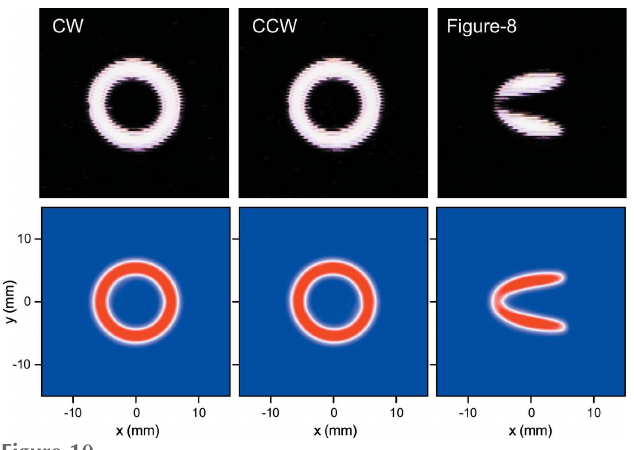
Figure 10 Top: profiles of SR measured by inserting a fluorescent screen. Bottom: radiation power density calculated with the measured field